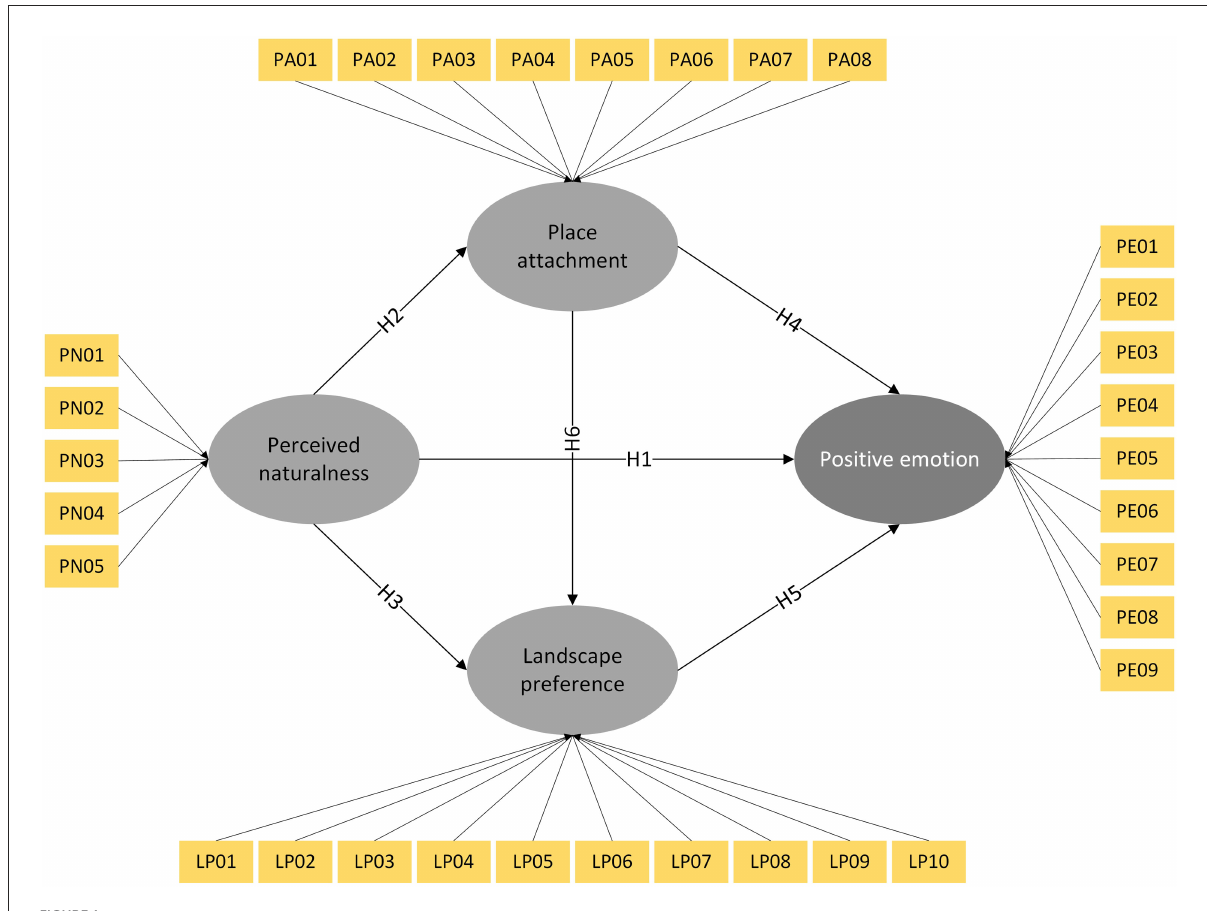
FIGURE1 The diagram of the conceptual